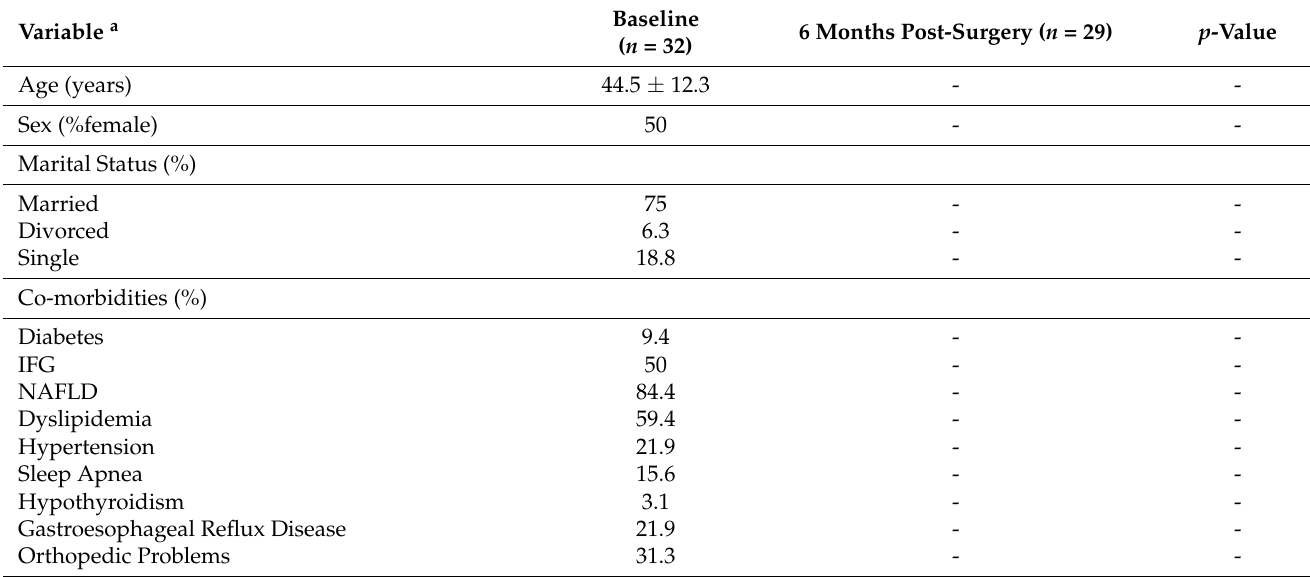
Table 1. Characteristics of the study participants at baseline and at 6 months